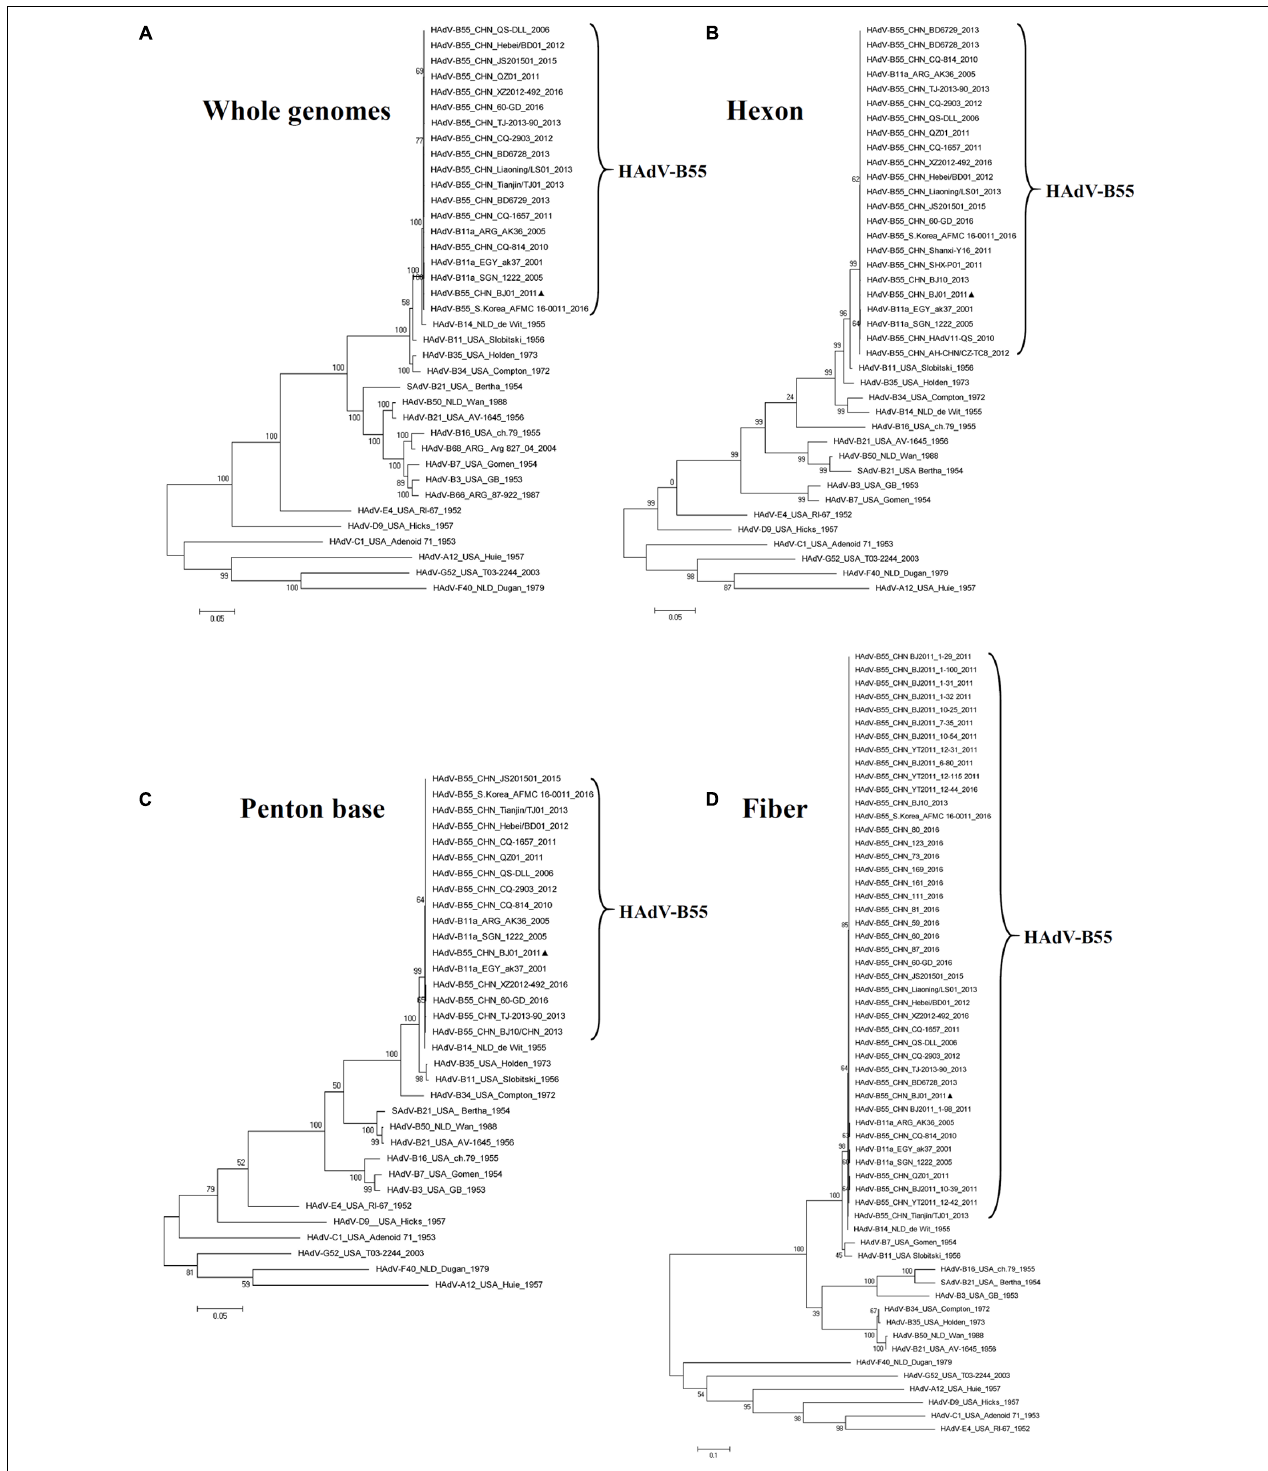
FIGURE 3 | Phylogenetic analysis of HAdV-B55 strain BJ01. The HAdV nucleotide sequences of the whole genome (A) , hexon (B) , penton base (C) , and fiber (D) genes, were analyzed for their phylogenetic relationships. For reference, taxon names include the corresponding GenBank accession number, country of isolation, strain name, year of isolation, and genome type. Bootstrapped, maximum likelihood trees with 1,000 replicates were constructed using the MEGA 5.05 software (see Footnote 5). and by applying default parameters, with a maximum-composite-likelihood method. Bootstrap numbers shown at the nodes indicate the percentages of 1,000 replications producing the clade. The scale bar indicates units of nucleotide substitutions per site. The sequences used for phylogenic analyses are retrieved from GenBank and summarized in Table 1 . Sequences from strain BJ01 are noted for reference ( (cid:78) ).